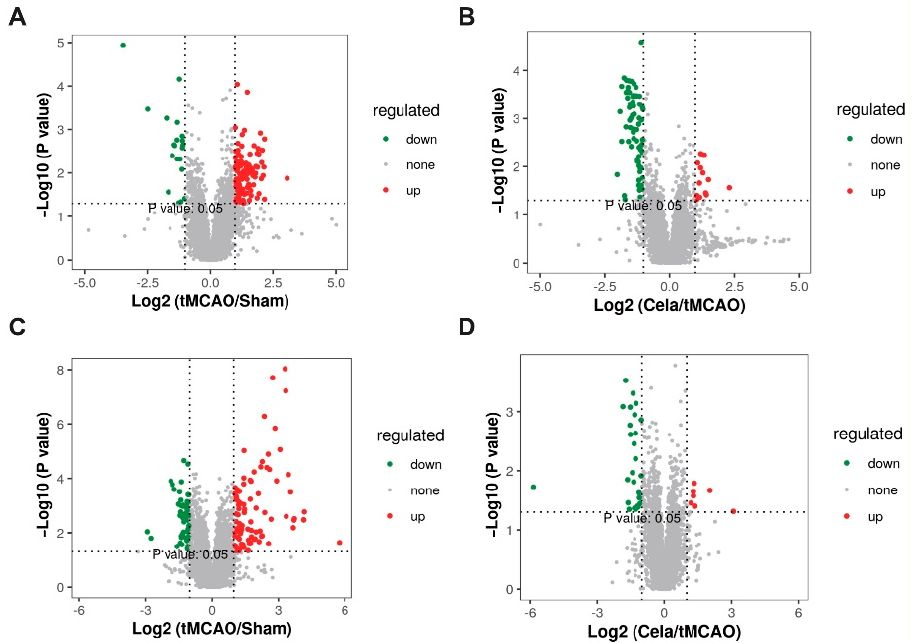
Figure 3. The volcano map showed the differential lipids expression level among the Sham mice, tMCAO mice and Cela-treated tMCAO mice. The red color indicates the upregulated lipids, while green color represents the downregulated lipids. ( A ) plasma_tMCAO/Sham, ( B ) plasma_Cela/tMCAO, ( C ) brain_tMCAO/Sham and ( D ) brain_ Cela/tMCAO groups. In order to evaluate the key lipids which induced by stroke and celastrol treatment, we used a venn map to find the common lipids between tMCAO mice and Celastrol-treated there were 14 common DELs between brain_tMCAO/Sham and brain_Cela/tMCAO groups (Figure 5, Red Arrow). Compared with Sham group, the levels of 13 lipid metabolites (i. 2-hydroxybutyric acid, ii. PS (dime(11,3)/dime(11,5)), iii. PI (40:5), iv. 1,2-di-(9z,12z, 15z-octadecatrienoyl)-3-(galactosyl-alpha-1-6-galactosyl-beta-1)-glycerol, v.